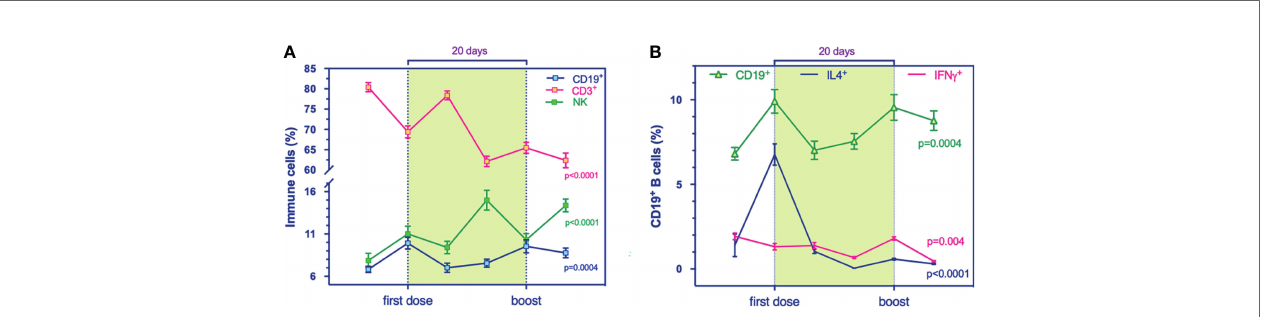
FIGURE 1 | Global landscape of the immune phenotypic changes in a longitudinal cohort who received mRNA-based vaccination against SARS-CoV-2. (A, B) Flow cytometry analysis for immune cell compartments panel. (A) prevalence % of total T (CD3 + , purple, p < 0.0001), B (CD19 + , blue, p = 0.0004), and NK (CD56 + , green, p < 0.0001) cells during the timing vaccination. (B) Prevalence % of IL4 + -producing B cells (blue, p < 0.0001) and IFN g + -producing B cells (purple, p = 0.004) compared to total B cells (green, p = 0.0004) at the stages of immunization. Multivariable mixed models for repeated measures adjusted for confounders (time, age, sex, responders) were performed.